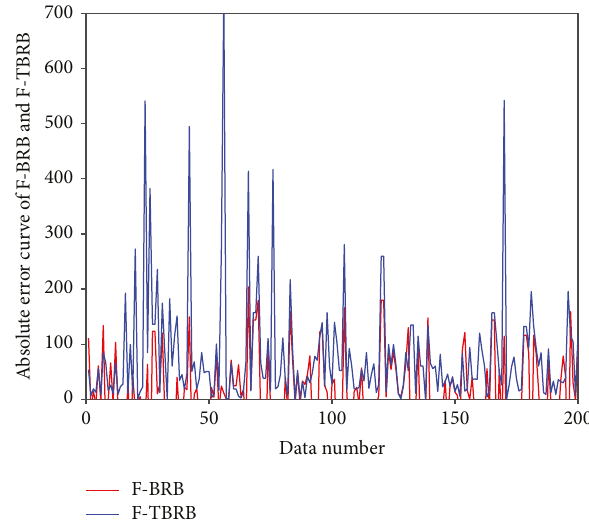
Figure 9: The absolute error of F-BRB and